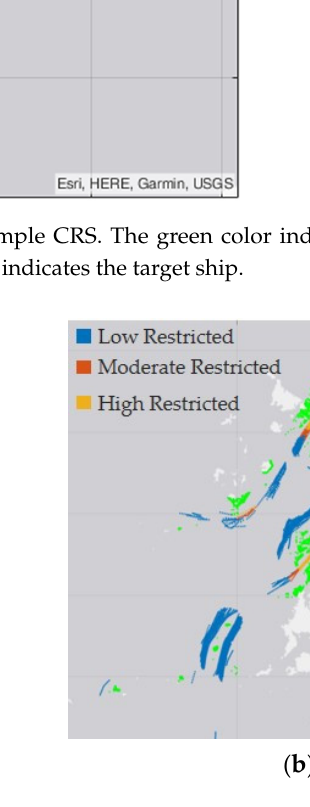
Figure 11. Ratio and trajectory distribution of the first stage clustering result: ( a ) The ratio of each area, ( b ) the Spatial distribution of each cluster.